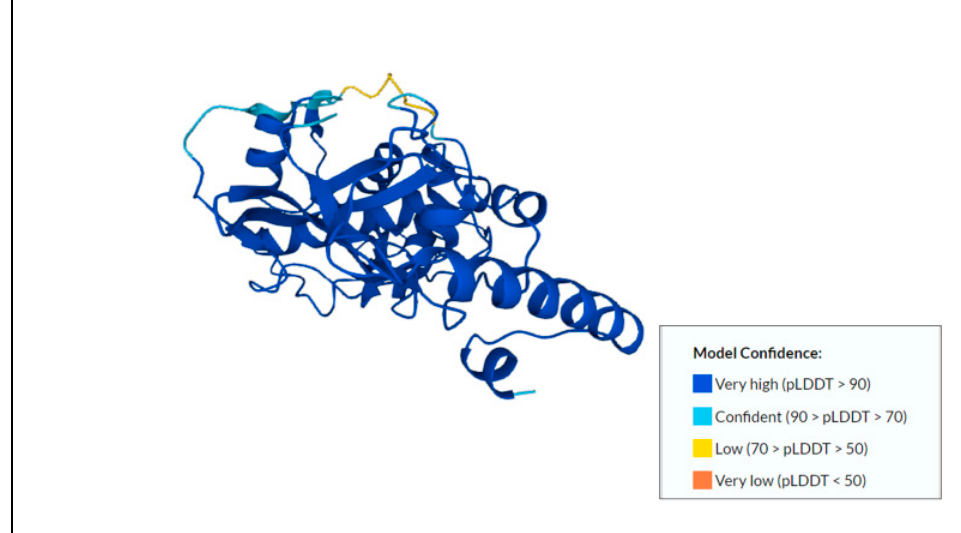
Figure 2. Predicted protein structure of cysteine proteinase 5 [41,49,50] (https://www.uniprot.org/uniprotkb/Q06FF8/entry, accessed on 25 October 2022). 2.3. Entamoeba Histolytica Lipopeptidophosphoglycan (EhLPPG)